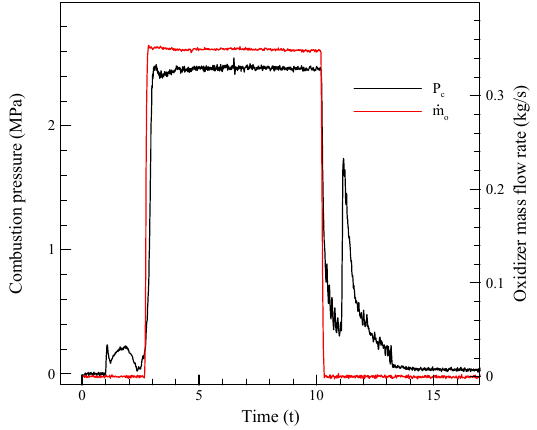
Figure 11. Experimental curves of the ground firing test.